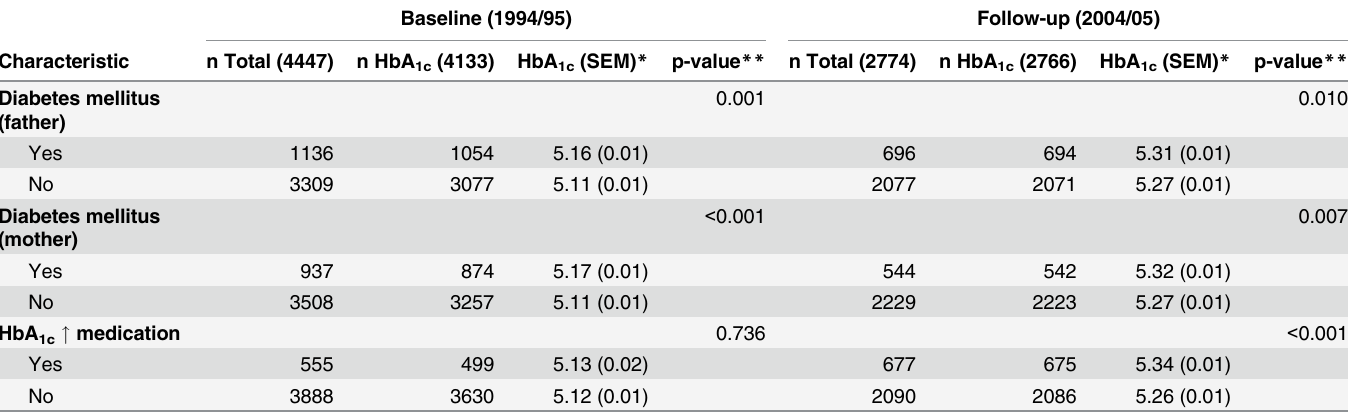
upper tertile was significantly lower ( β = – 0.29% (95% CI: – 0.45 to – 0.12)) compared with x individuals with no intake of carotenoids (p = 0.0006). Unlike in the main analysis, the differ- levels of 0.25% (95% CI: 0.11 to 0.39) between those with the highest ence in baseline HbA 1c intakes of carotenoids compared with those with no intake was statistically significant. levels, the results In the smoking status-stratified analyses of carotenoid intake and HbA 1c for current and former smokers were pooled together, as they did not differ substantially (data level not shown). A longitudinal inverse association of the upper carotenoid tertile with HbA 1c = – 0.43% (95% CI: – 0.63 to – 0.24), was significant in participants who never smoked ( β x = – 0.11% (95% CI: – 0.39 to 0.17), p < 0.0001), but not in current or former smokers ( β x p = 0.451) (see Fig 1). Never smokers with carotenoid intakes in the upper tertile had higher values than never smokers with no intake of carotenoids ( β = 0.33 (95% CI: baseline HbA 1c 0 0.18 to 0.48), p < 0.0001)